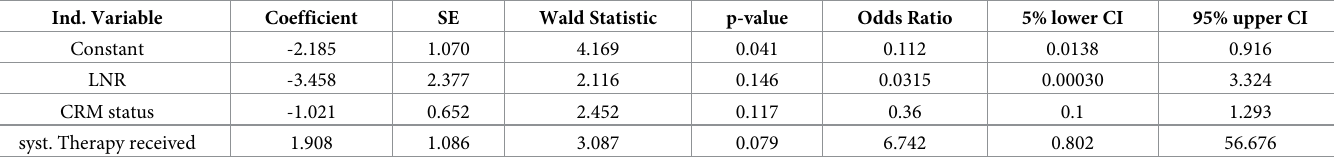
Table 2. Results of the multivariate logistic regression to predict long-term survival > 36 months. Ind. Variable